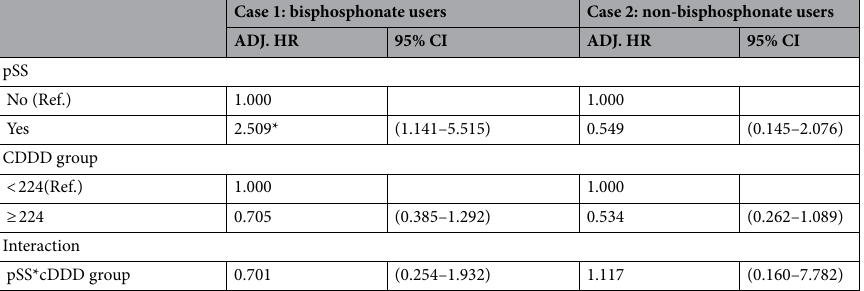
Table 5. Interaction between pSS and cDDD group in bisphosphonate and non-bisphosphonate users. (1) *0.01 ≤ p < 0.05, **0.0001 ≤ p < 0.01, *** p < 0.0001. (2) ‡ ADJ. HR was adjusted by sex, comorbidities, and age at the initiation of bisphosphonate use. pSS primary Sjogren syndrome, cDDD cumulative dose with defined daily dose, 95% CI 95% confidence interval, ADJ. HR adjusted hazard ratio, Ref